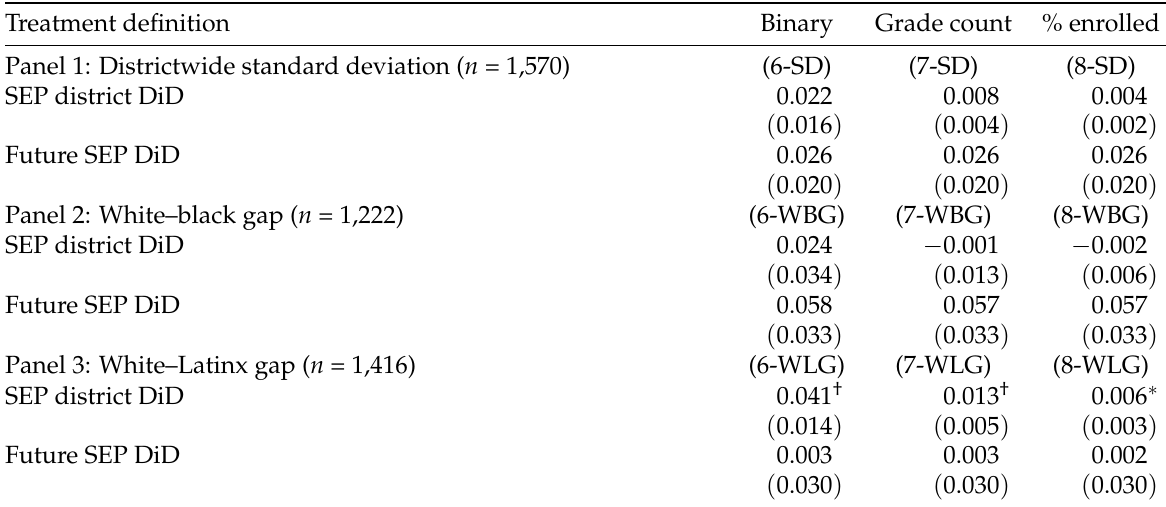
Table 5: DiD of district-level achievement inequality on SEP status. Treatment